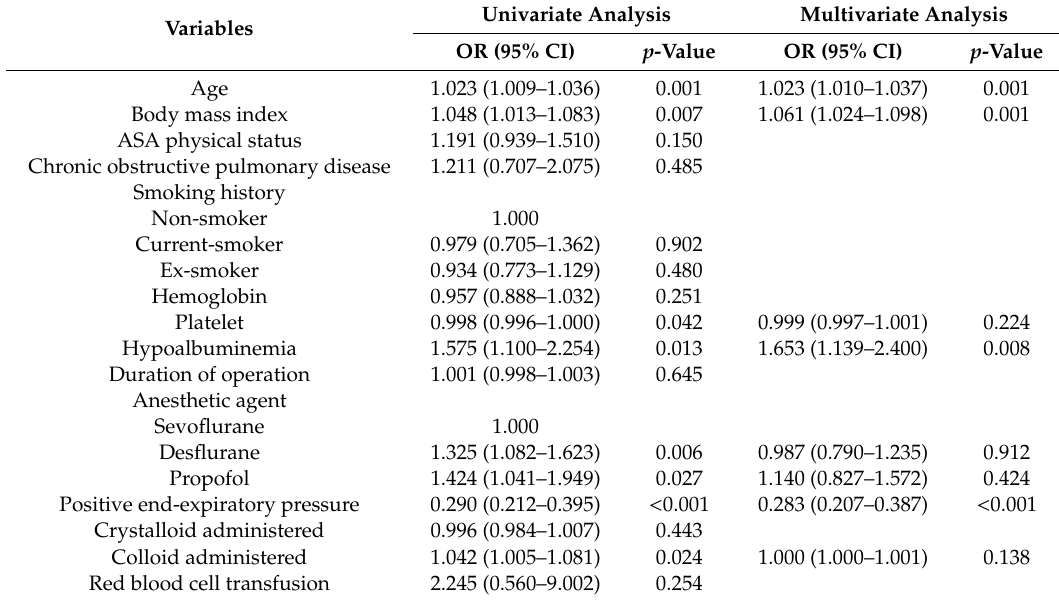
Table 3. Univariate and multivariate logistic regression analyses of factors predictive of postoperative pulmonary